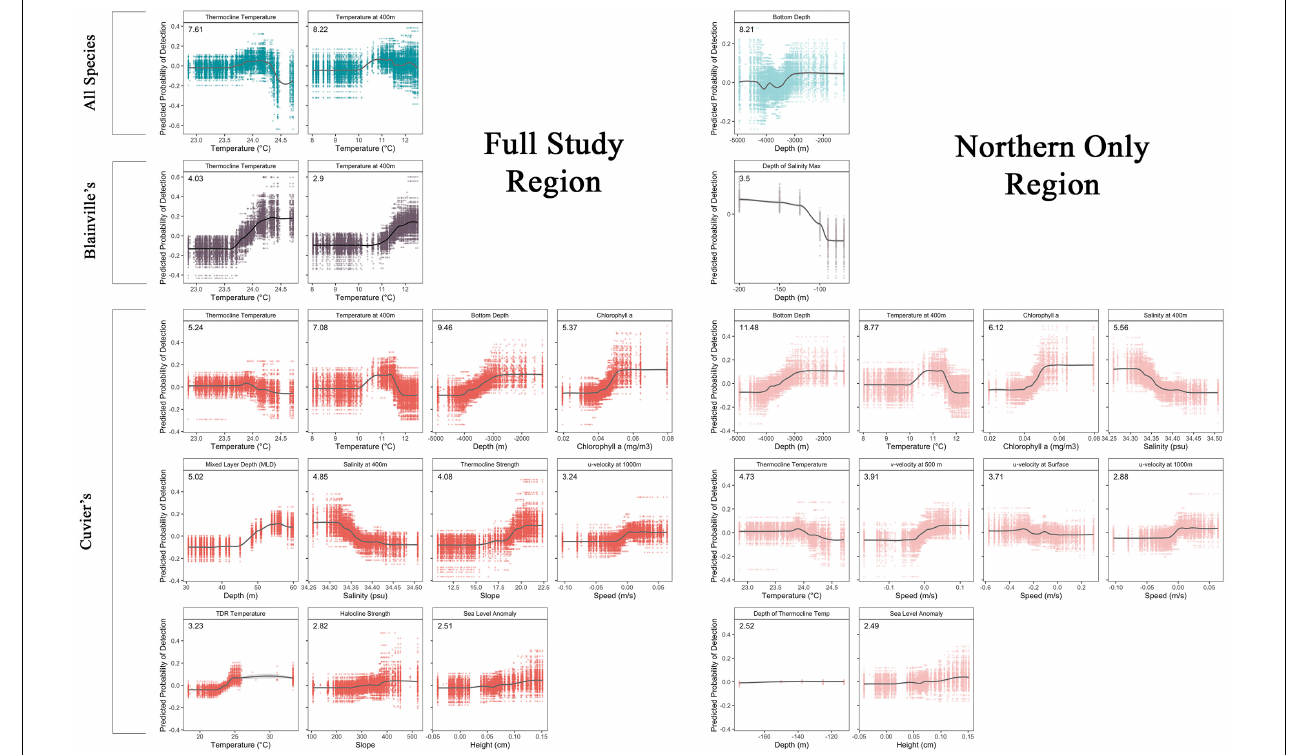
FIGURE 5 | Accumulated local effects (ALE) plots for the six Ensemble Random Forest (ERF) models. Each plot shows the ALE for each of the 200 random forest models that make up the ERF with a LOESS smoother line showing the ERF trend. Colors for each model are the same as in Figure 4 with darker shades (left side of figure) representing models for the full study region and lighter shades (right side of figure) are models for the northern region only. Only covariates with a mean decrease accuracy of greater than 5% of the total encounters are shown; the mean decrease accuracy is listed in the top left corner of each